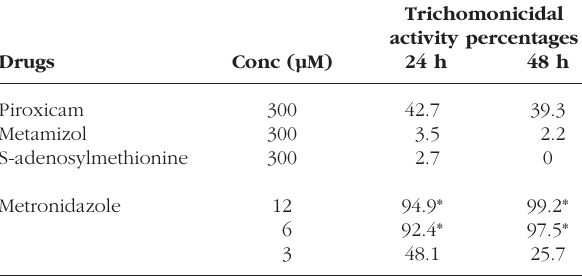
Table II. – In vitro cytostatic or cytocidal (*) activity of piroxicam, metamizol, and S-adenosylmethionine against Trichomonas vaginalis. Values are averages of two independent experiments with six repli-